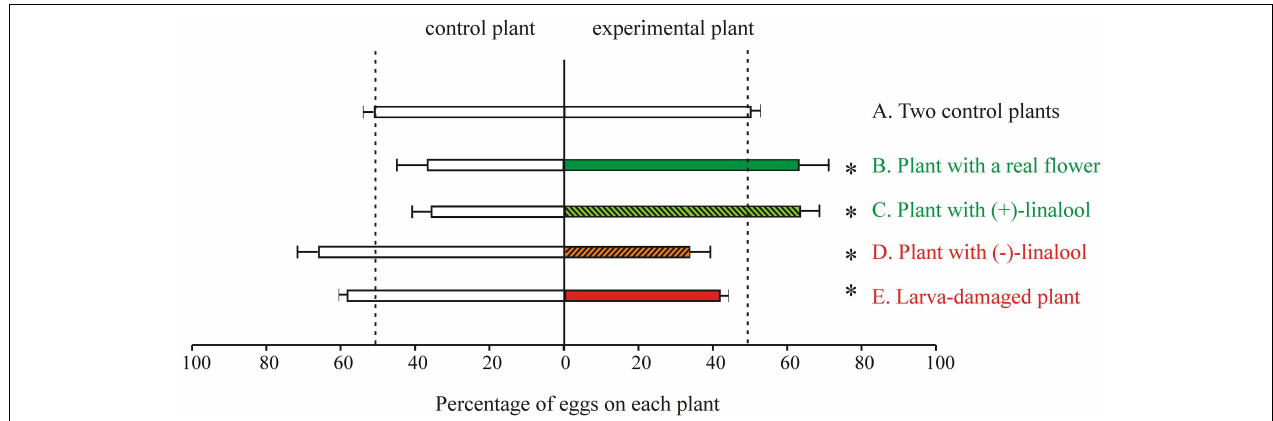
FIGURE 5 | Oviposition behavior of M. sexta in the laboratory. In all cases single mated females were offered a choice between a control and a test plant in a flight tent (as shown in Figure 1C ) and allowed to oviposit during 10min after take-off. Plant pairs of the jimsonweed D. wrighttii (A–D) or tomato ( Solanum lycopersicum ) (E) were used. In (A) two control plants were offered to control for spatial asymmetries ( n = 25 ). The following experimental series were conducted: (B) a plant with a newly opened flower vs. a plant with a paper flower ( n = 12 ); (C,D) a plant with a paper flower